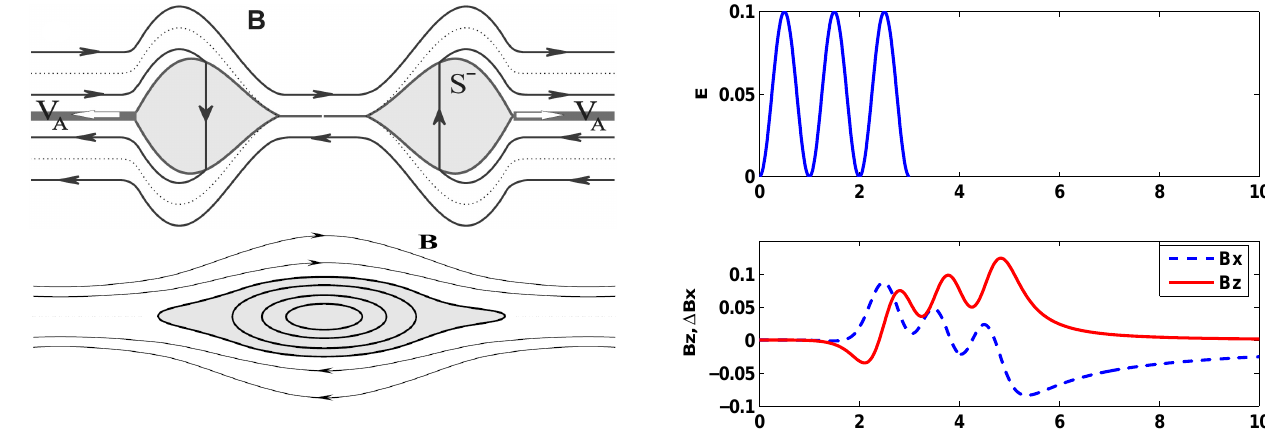
Fig. 1. Magnetic structure of an NFTE bulge according to the model of time-dependent Petschek-type reconnection (upper panel): Cur- rent sheet separating two plasma domains with opposite magnetic fields B decays into a system of MHD discontinuities and shocks S , which form two outflow bulges propagating in opposite directions with the Alfv´en speed V A . The dotted line is a separatrix between the reconnected magnetic flux and the non-reconnected one. The shaddowed area represents the bulge itself. Lower panel: Magnetic structure of a plasmoid/flux rope according to the model of multiple X-line reconnection.